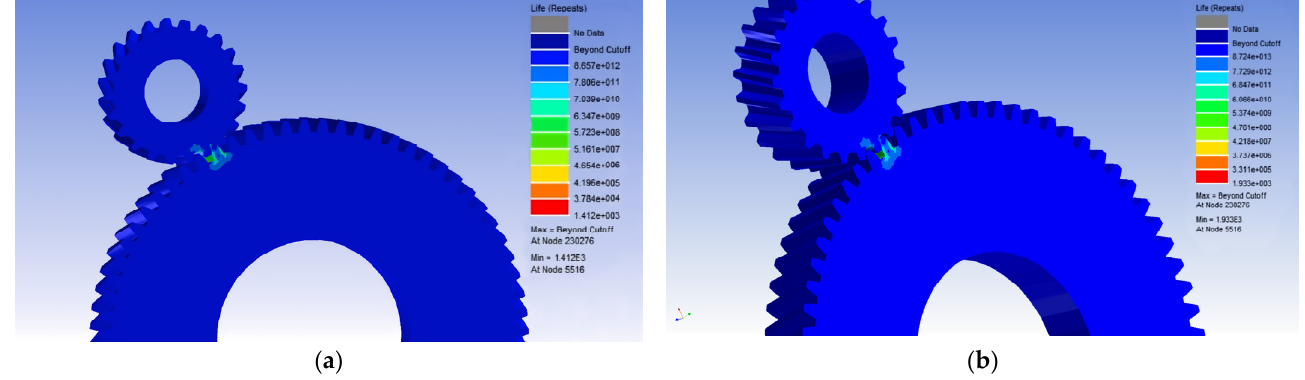
Figure 8. Simulation analysis results of gear fatigue life prediction: ( a ) fatigue life simulation of gears based on program load spectrum and ( b ) fatigue life simulation of gears based on actual loads.